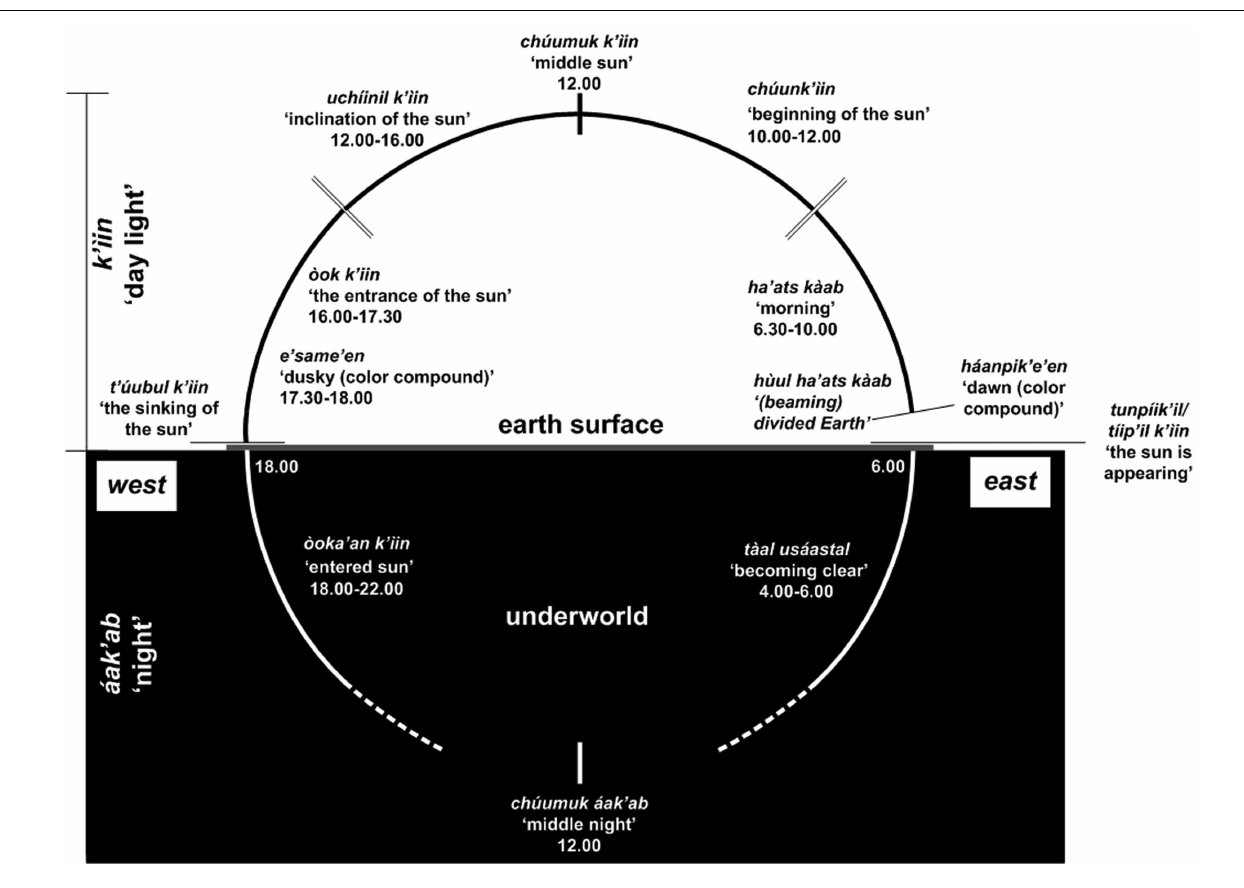
FIGURE 1 | Linguistic division of the